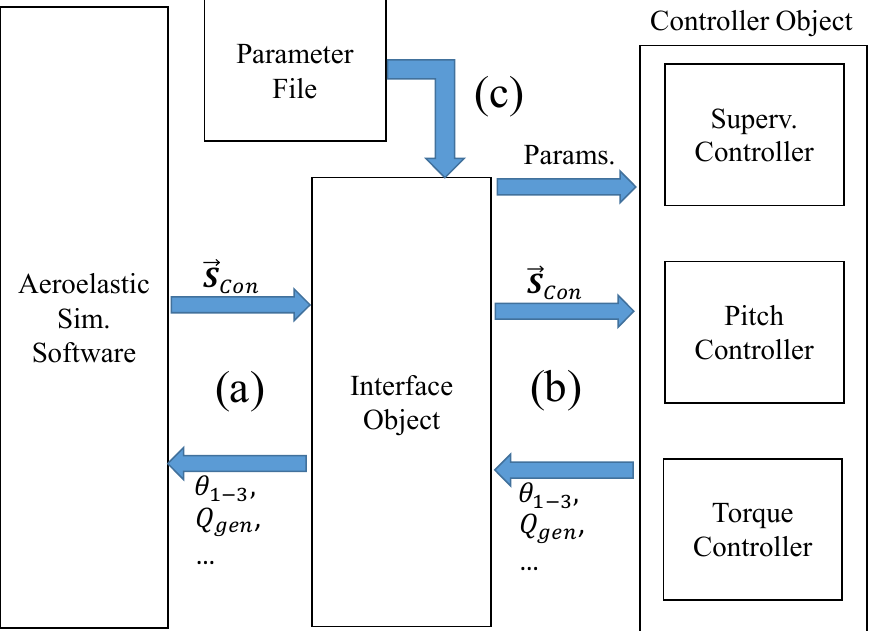
Figure 1. Graphical representation of the controller architecture. The communication with the aeroelastic software is done in two stages using an interface and a controller object. The controller parameters are passed through an external parameter file. (cid:126) S Con stands for controller